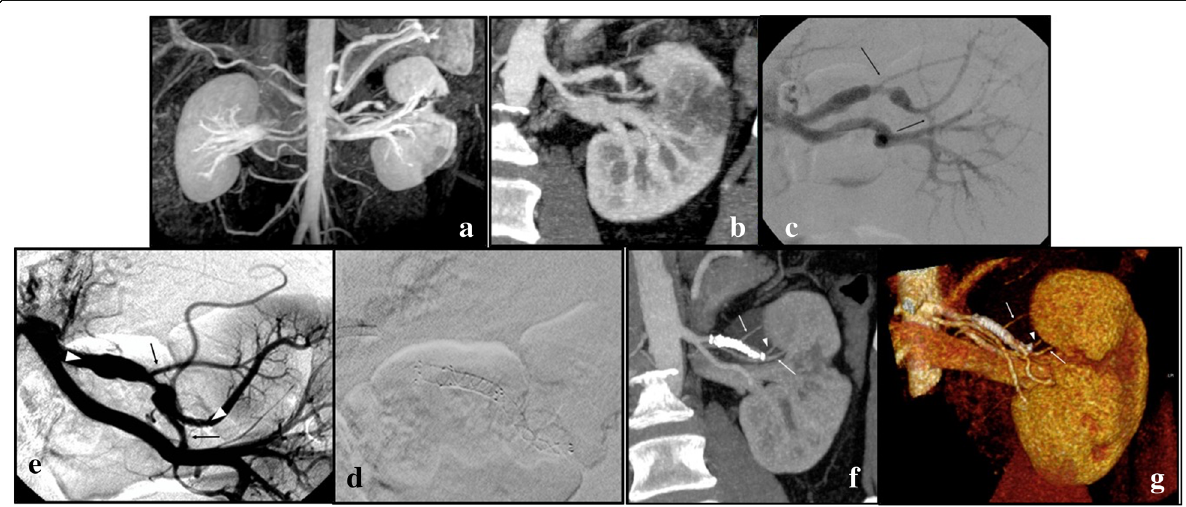
Fig. 3 a - g Coronal CTA ( a ) and 3D MRA imaging ( b ) at baseline, showing a bilobate VAP of the upper branch of the left renal artery and an ipsilateral hypodense-hypointense wedge-shaped parenchymal area of renal infarction. Selective renal artery DSA ( c – e ) before and after the deployment of two Fred 4/18/12mm and 3.5/31/24mm flow diverter stents, which are placed across two branching vessels (arrows), arising from the pseudoaneurysmatic artery (arrowheads in ( e ) show distal and proximal landing zone of the stents). Coronal CTA and VR imaging ( f - g ) at the 12-months follow-up show complete exclusion of the VAP, the parent vessel distally to the FDS (arrowhead) is patent as well as the stented sidebranches